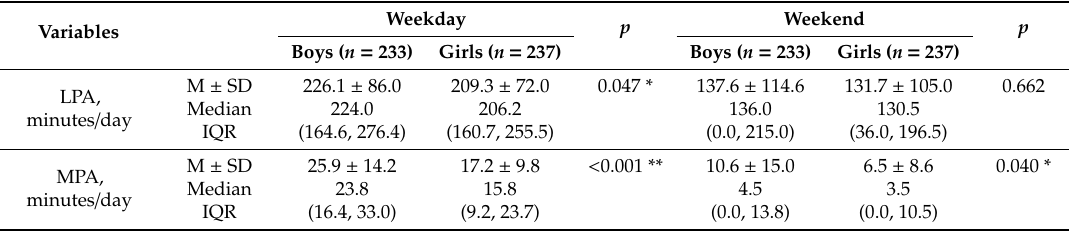
Table 3. Time spent in objectively measured PA and SB patterns for adolescents on weekdays and